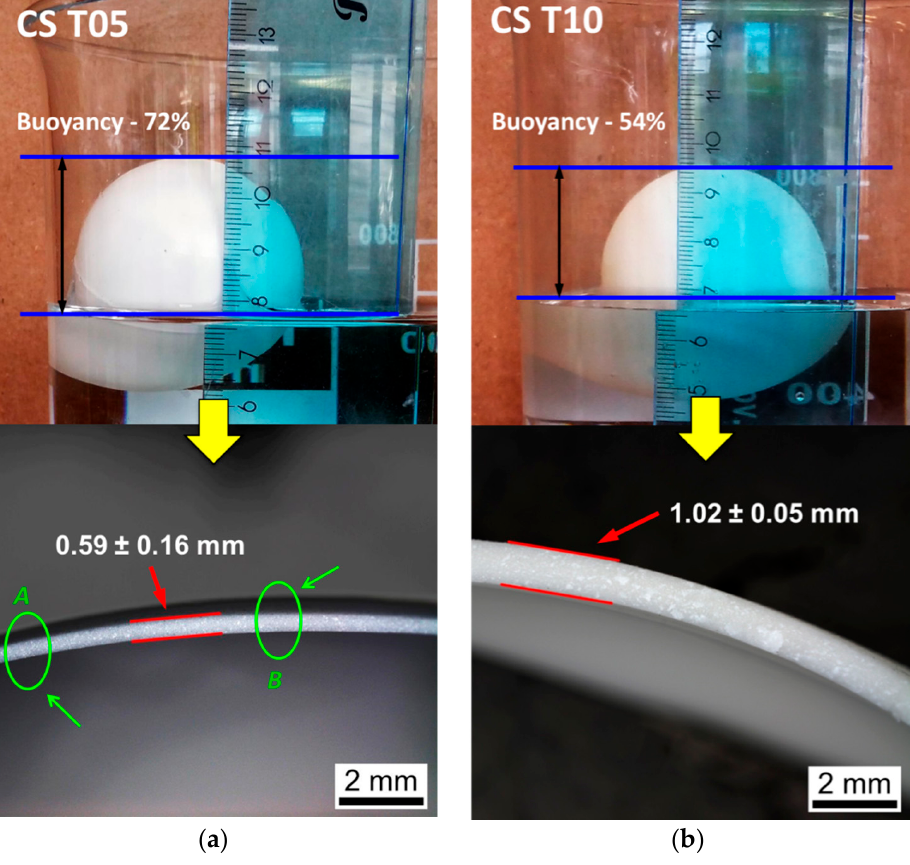
Figure 6. Buoyancy tests in simulated sea water and wall thickness results for the alumina based ceramic sphere: ( a ) CS T05 and ( b ) CS T10.